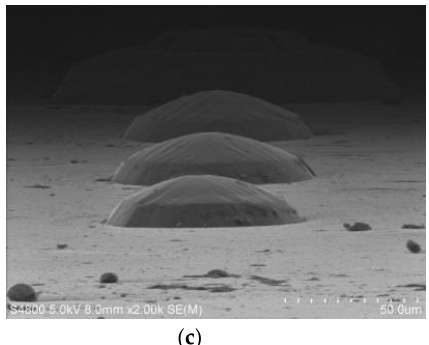
Figure 9. Three-step etching SEM of the spherical cap-like structure. ( a ) The first etching was patterned by a 50 μ m diameter circular mask to form a circular truncated cone; ( b ) the second etching was performed by a 30 μ m diameter mask to chamfer the top edge’s angle; ( c ) the mask was removed at the third etching and a spherical cap-like structure is formed.